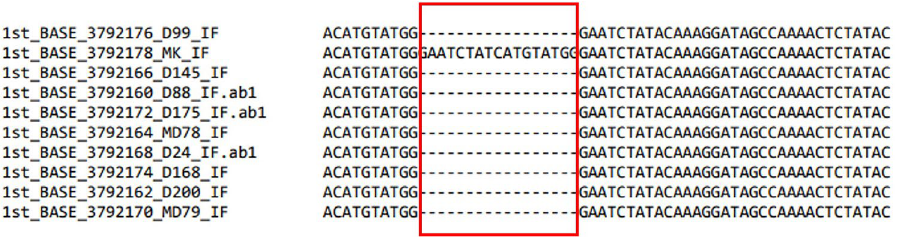
Figure 1. DNA sequence alignment of nadhA from MK, D88, D24, D99, D145, D168, D175, D200, MDUR78 and MDUR79. The red box shows the obvious comparison sequence among 10 durian varieties in which MK sequence contain unique sequence of 17